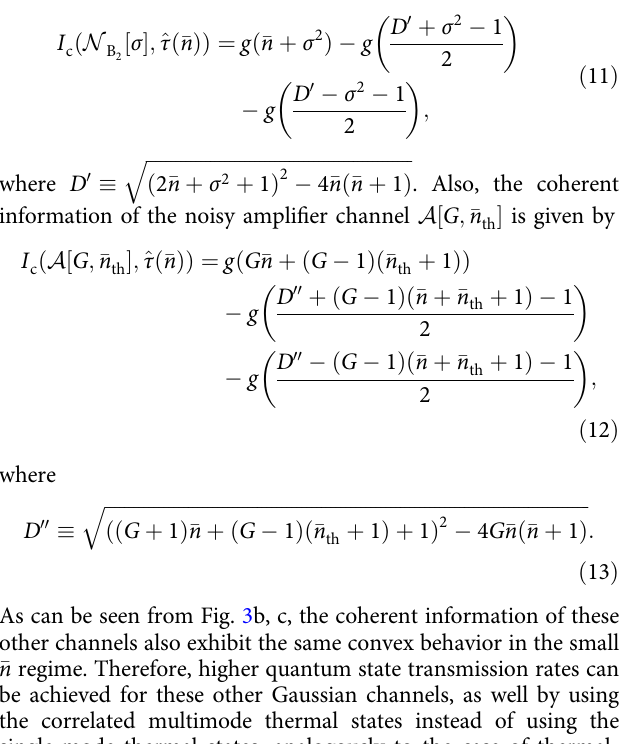
panel of Fig. 4, the coherent information I lines) is larger than, equal to, and smaller than the